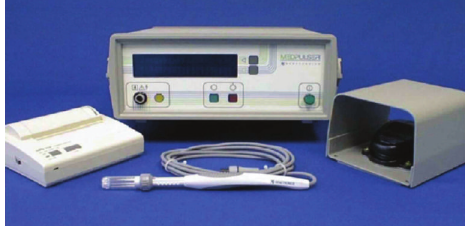
Figure 1: MedPulser electroporation device from Genetronics Biomedical Corporation (San Diego, California, USA). Permission granted by Genetronics Inc Pulse generator, foot switch, and appli- cator.